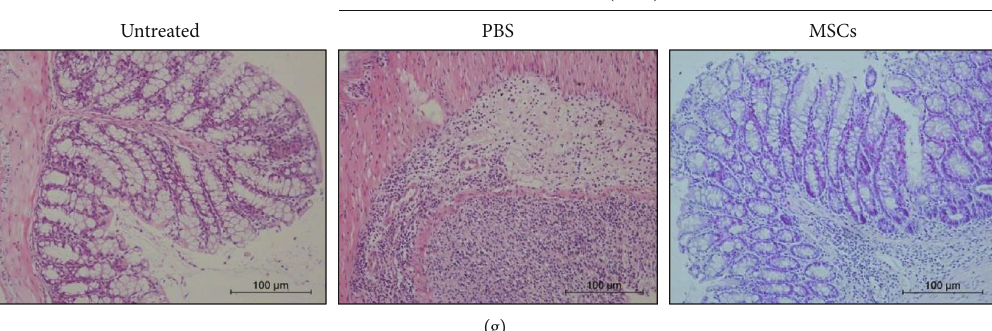
Figure 4: HUC-MSC treatment protects against DSS-induced acute colitis. Colitis was induced by oral administration of 3.5% (wt/vol) DSS in sterile drinking water for 6 days. Mice were injected intravenously with 2 × 10 6 HUC-MSCs in 200 μ l phosphate-bu ff ered saline (PBS) per mouse in the cell injection group or with 200 μ l PBS per mouse in the DSS-treated group at day 1, day 3, and day 5. ∗ p < 0 : 05 ; ∗∗ p < 0 : 01 ; ∗∗∗ p < 0 : 005 . Error bars: mean ± SD . (a) Survival rate of mice treated with 5% (wt/vol) DSS and di ff erent doses of HUC-MSCs. The dose of cells injected into mice was 1 × 10 5 , 2 × 10 5 , and 5 × 10 5 per mice. (b) Weight changes of mice with or without 3.5% (wt/vol) DSS treatment. (c) Disease activity index (DAI) scores after DSS administration. Clinical evolution was monitored by weight change, stool consistency, and presence of fecal blood. (d) Statistics of colon lengths in normal, DSS-, and HUC-MSC-treated groups. (e) Evaluation of colonic permeability with FITC-dextran in serum of colitis mice. (f) Evaluation of colonic permeability with western blot. (g) Hematoxylin-eosin (HE) staining of colons. Intravenous injection of HUC-MSCs promotes histological improvement. Colon histology demonstrated intravenously administered HUC-MSCs reduced the extent of the in fl amed area, crypt damage, and in fi ltration of in fl ammatory cells caused by